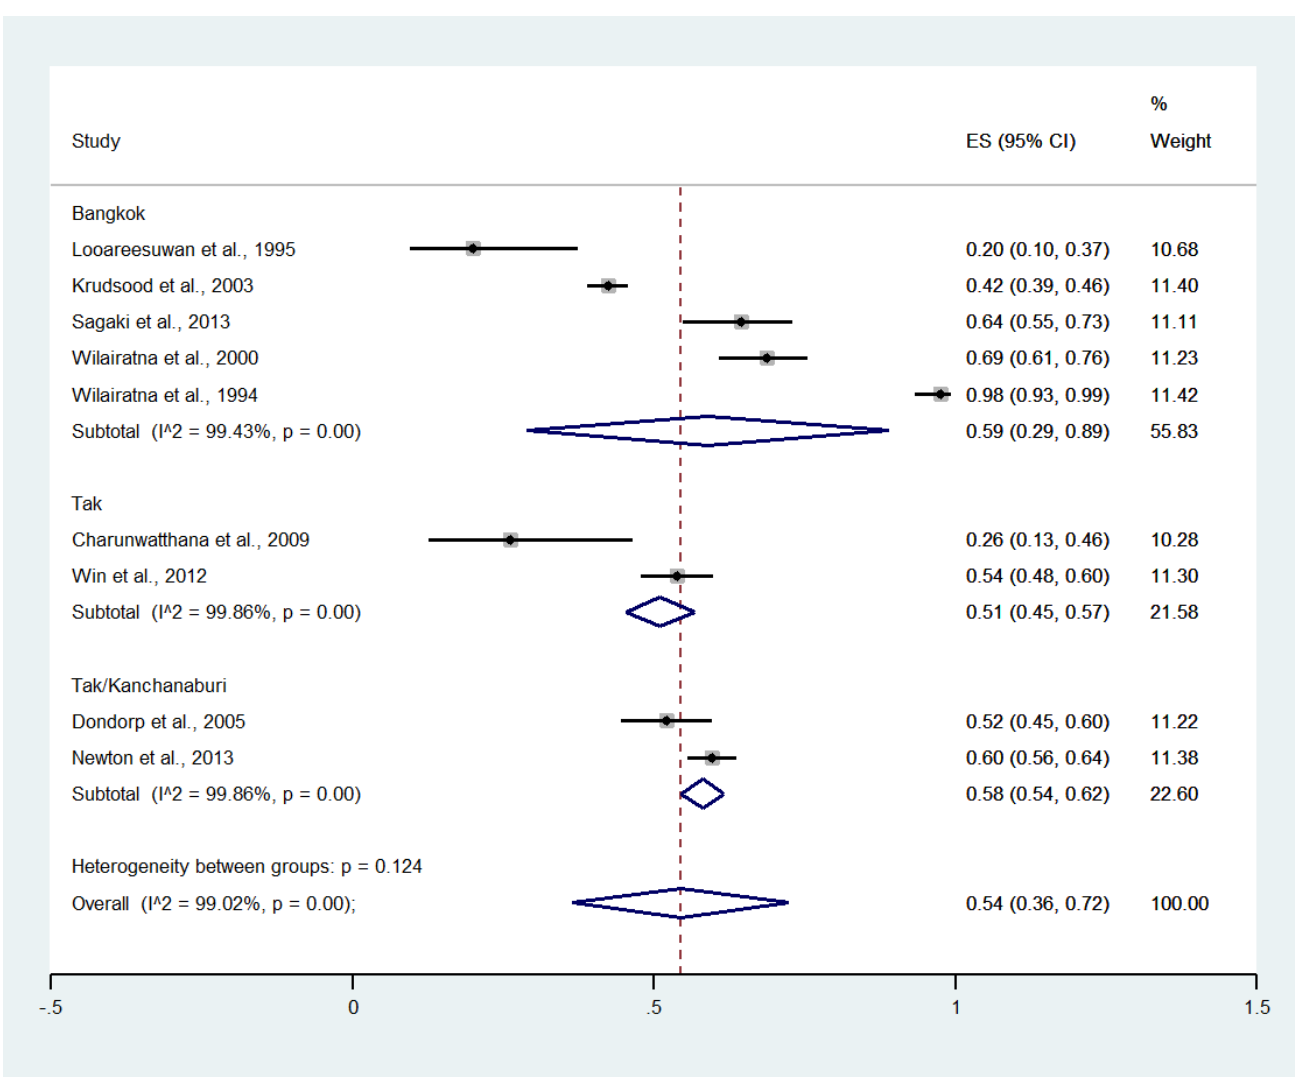
Figure 4. Subgroup analysis of the pooled prevalence of jaundice among patients with severe malaria in Thailand. The label for the x-axis is the scale of estimated prevalence. Abbreviations; ES, estimated prevalence; CI, confidence interval .